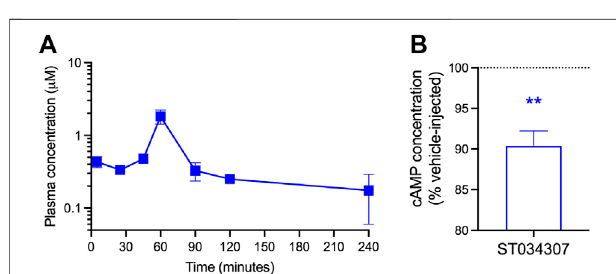
FIGURE 4 | ST034307 plasma concentration peaks at 60 min after subcutaneous injection and reduces cAMP concentration in the DRG. (A) Plasma ST0304307 concentration versus time pro fi le after a single 10 mg/kg subcutaneous injection in mice. N = 2,3. (B) A 10 mg/kg subcutaneous injection of ST034307 causes a reduction in cAMP concentration in the DRG of mice. DRG were dissected 90 min after injection. Data was normalized to respective matched vehicle-injected controls. N = 6. ** p < 0.01 in one sample T test compared to